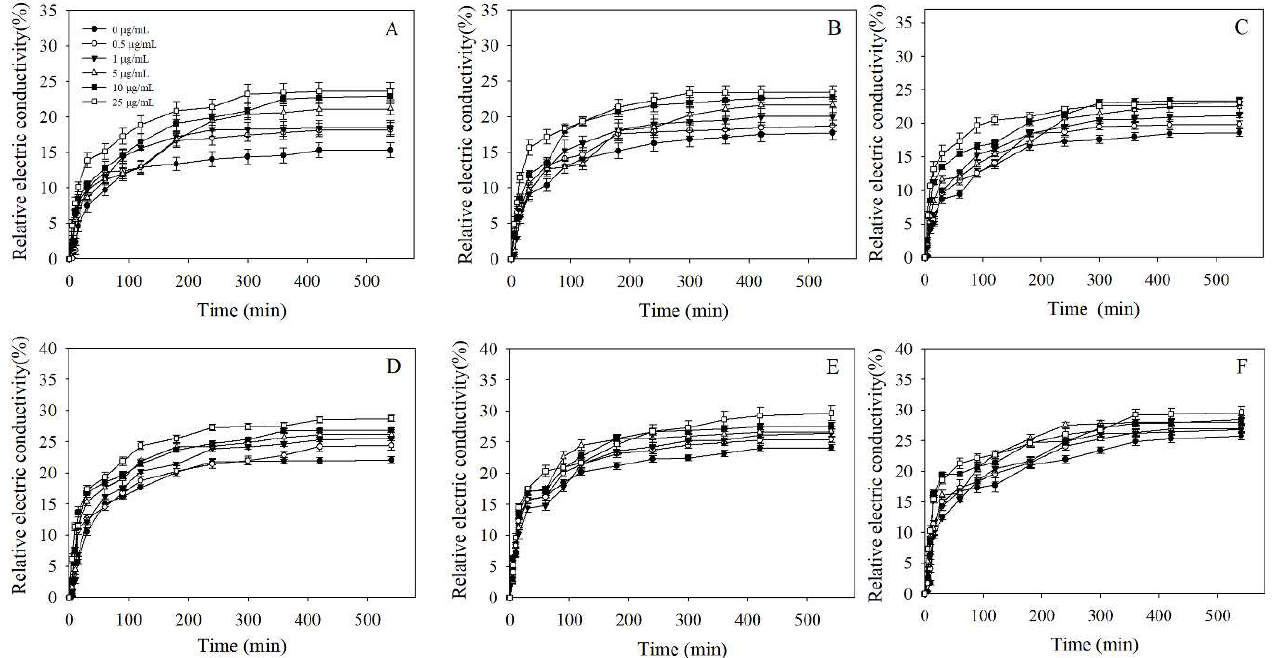
Figure 3. The relative electric conductivity of tebuconazole-resistant and -susceptible isolates exposed to varying concentrations of tebuconazole. Bars denote the standard deviation of two